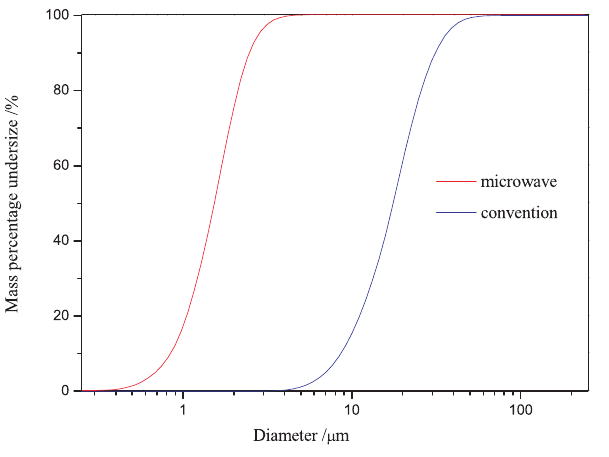
Fig. 8: Averaged size distributions of hematite calcined at